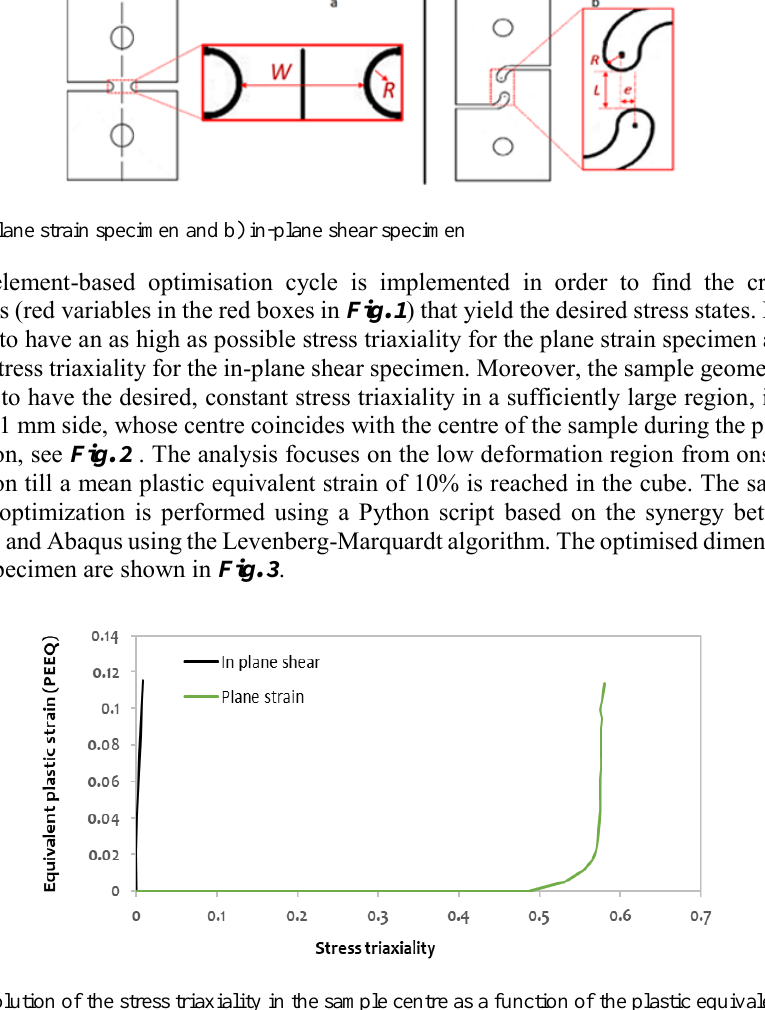
Fig. 2 .: Evolution of the stress triaxiality in the sample centre as a function of the plastic equivalent strain for the plane strain and in-plane shear